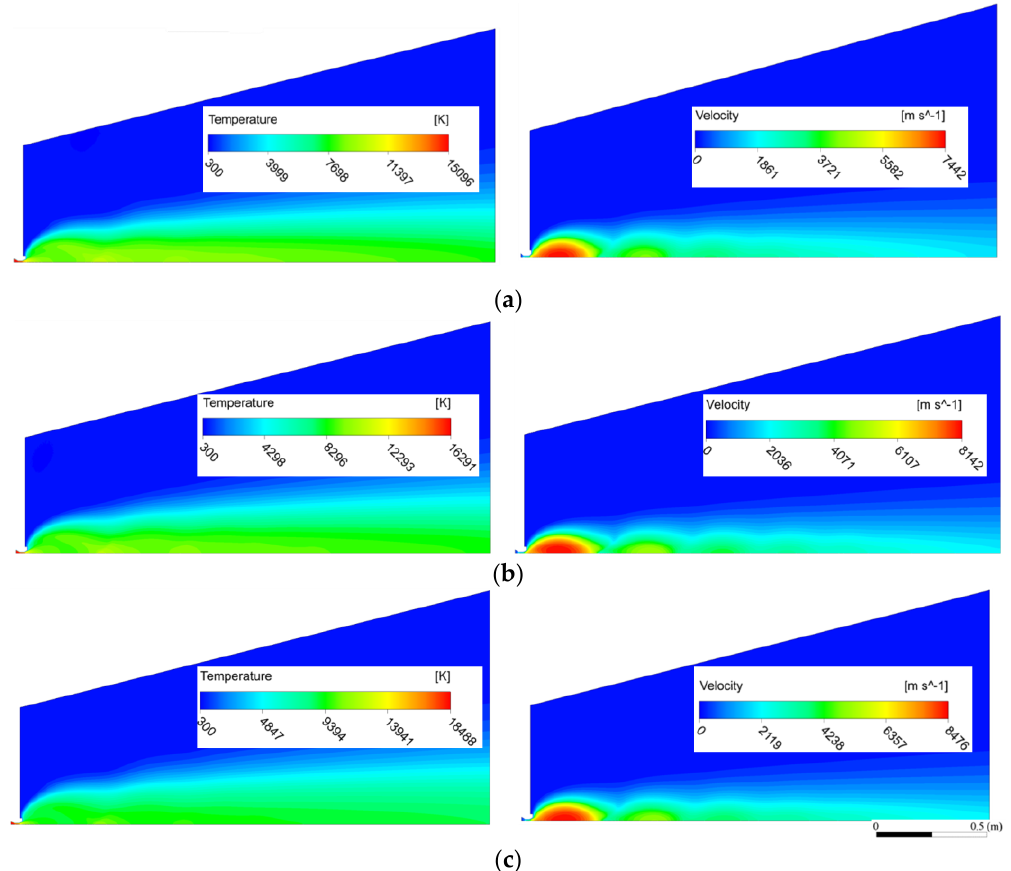
Figure 5. Temperature and velocity fields of the plasma jet for different net electric powers: ( a ) 50 kW, ( b ) 60 kW, and ( c ) 70 kW. 60 SLPM of argon, 30 SLPM of helium, chamber pressure: 100 Pa.